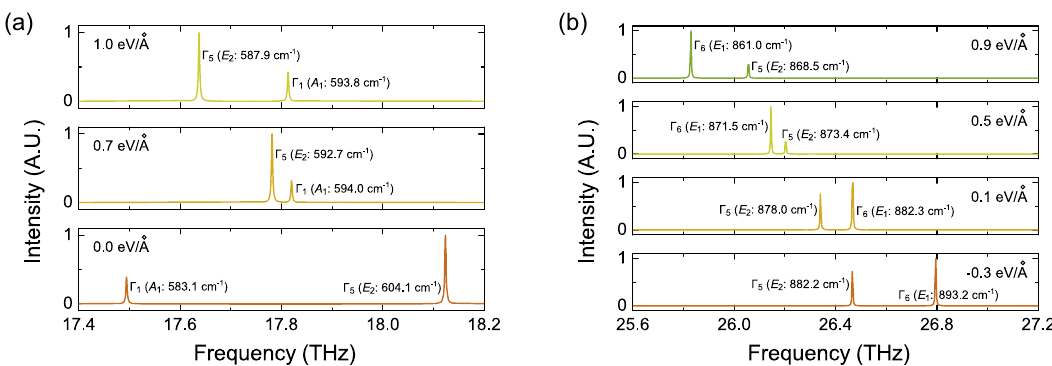
Fig. 5 Raman signature. Simulated Raman spectra (A.U. = arbitrary units) for a 7% and b 5% strained monolayer silicate Si 2 O 3 under various electric